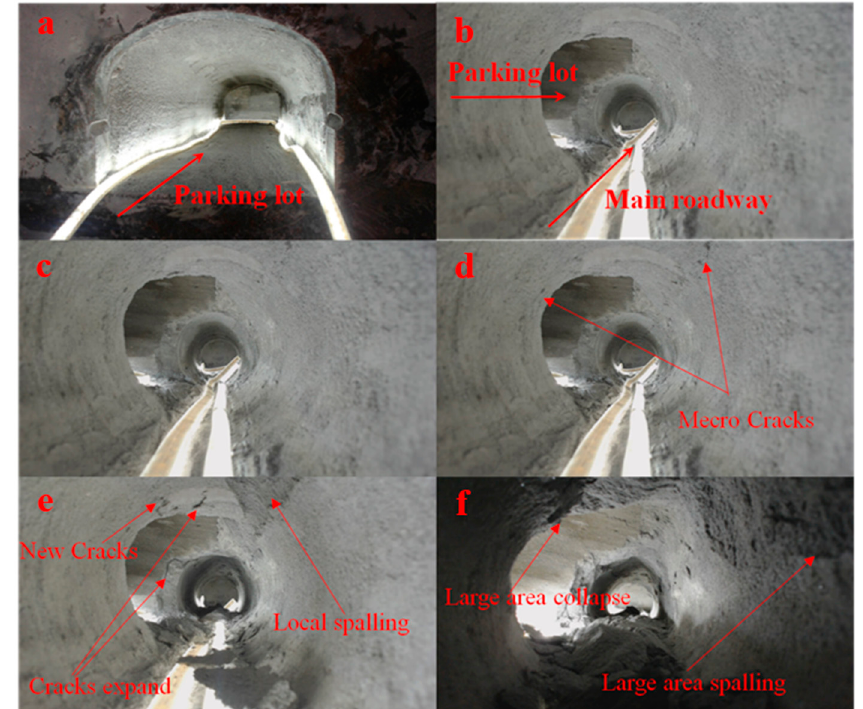
Figure 13. Pictures of excavation completion and overloading process of different parts in terms of ( a ) parking lot after excavation; ( b ) intersection of parking lot and main roadway after excavation; ( c ) intersection under the overloading of 1.6 P; ( d ) intersection under the overloading of 2.0 P; ( e ) intersection under the overloading of 2.2 P; and ( f ) intersection under the overloading of 2.4 P.